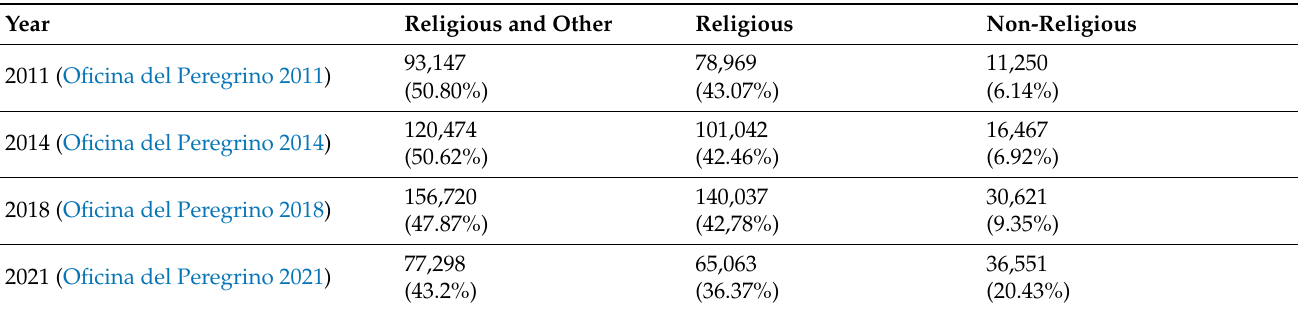
Table 1. Table documenting a sample of statistical trends in the motives of pilgrims over one decade of data collection by the Office of Pilgrims in